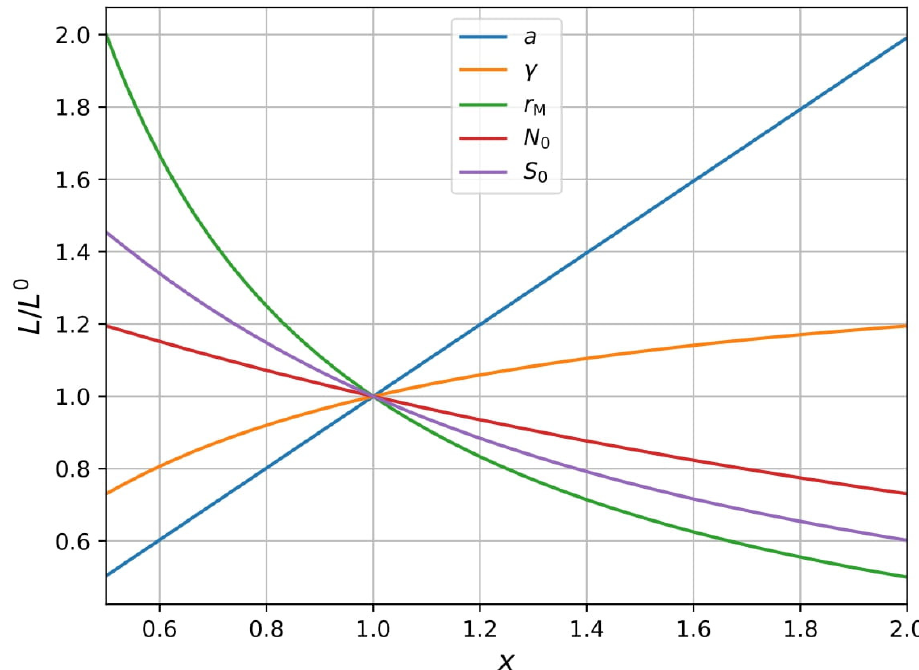
Figure 8. Influence of external ( N o , S o ) and internal ( γ , r m , a ) free parameters on the length L of the linearized part of the exponential phase of the growth curve (see Formula (11)). Here, L is scaled by L o ( x = L / L o ) where L o corresponds to the set ( a = 60 g/L, γ = 0.2, r m = 4 h − 1 , N o = 0.033 g/L, S o = 0.8 g/L).